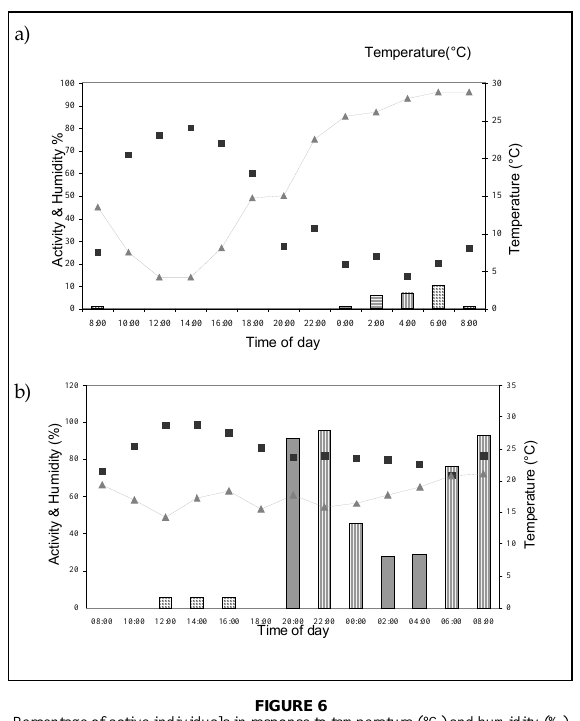
Figure 6 Percentage of active individuals in response to temperature (°C) and humidity (%) during (a) a dry sunny and (b) a humid